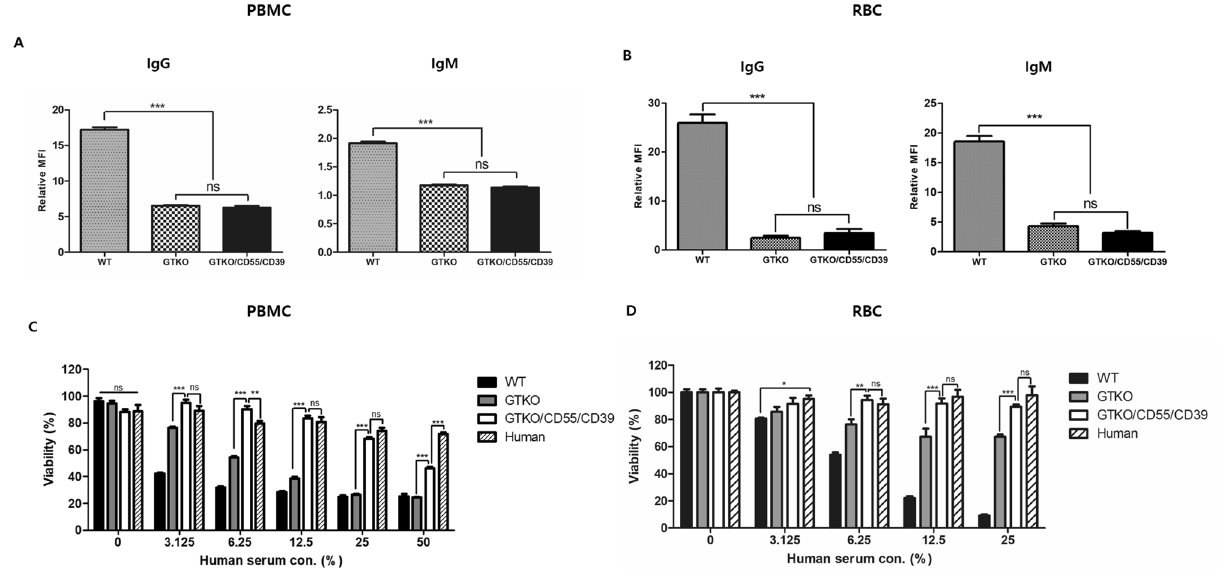
Figure 2. Prevention of humoral rejection on GTKO/CD55/CD39 pig in vitro. Human antibody binding to PBMCs ( A ) and RBCs ( B ). Both human IgG and IgM binding to cells from GTKO and GTKO/CD55/CD39 pig decreased compared with cells from wild-type pig. Data represented relative mean fluorescence intesnsity (MFI). Experiments were performed in triplicated (n = 1, ***P < 0.05, one-way analysis of variance). Inhibition of human complement mediated rejection on cells from GTKO/CD55/CD39 pig. PBMCs ( C ) and RBCs ( D ) from wild-type, GTKO/CD55/CD39 pig and human. These cells were incubated with various human complement serum concentration, and the viability was represented by calculation with absorbance of CCK-8 (PBMCs) or viable remaining cells (RBCs). Experiments were performed in triplicated (n = 1; * P < 0.05; **P < 0.01; ***P < 0.001; ns, non-significant; two-way analysis of